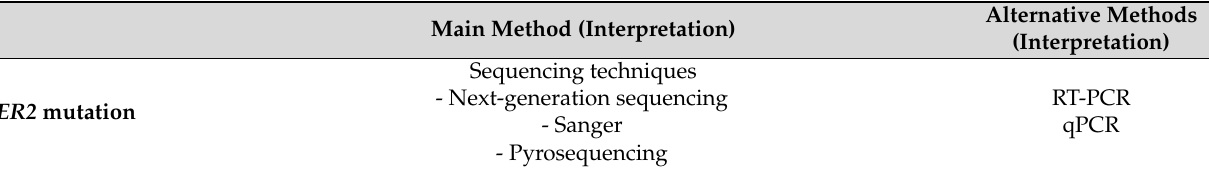
Table 1. Techniques for detecting HER2 molecular alterations and recommendations for interpretation. Main Method (Interpretation) Sequencing HER2 mutation